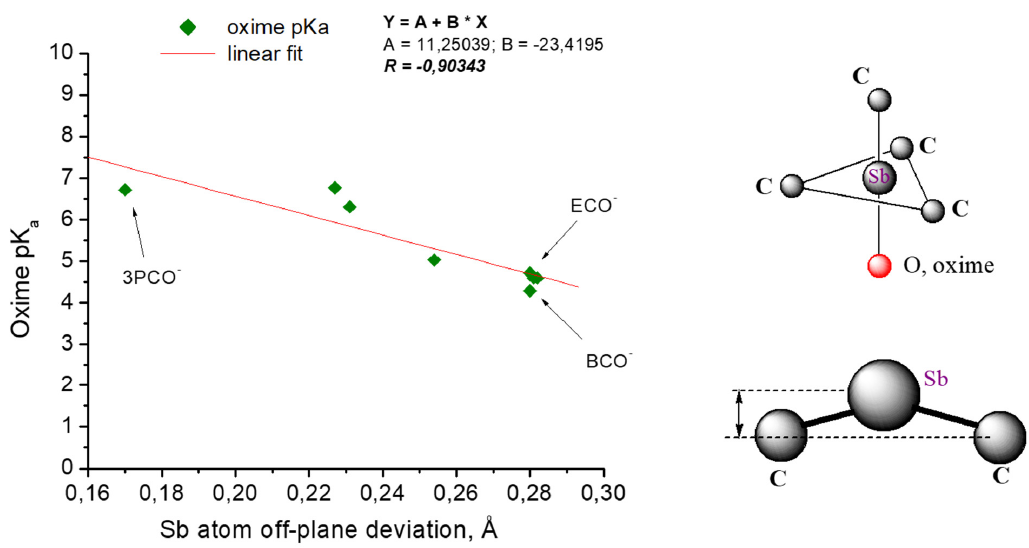
Figure 6. Observed correlation in geometry of the antimony(V) environment such as out–of–plane distance and acidity of coordinated to it cyanoxime moiety.